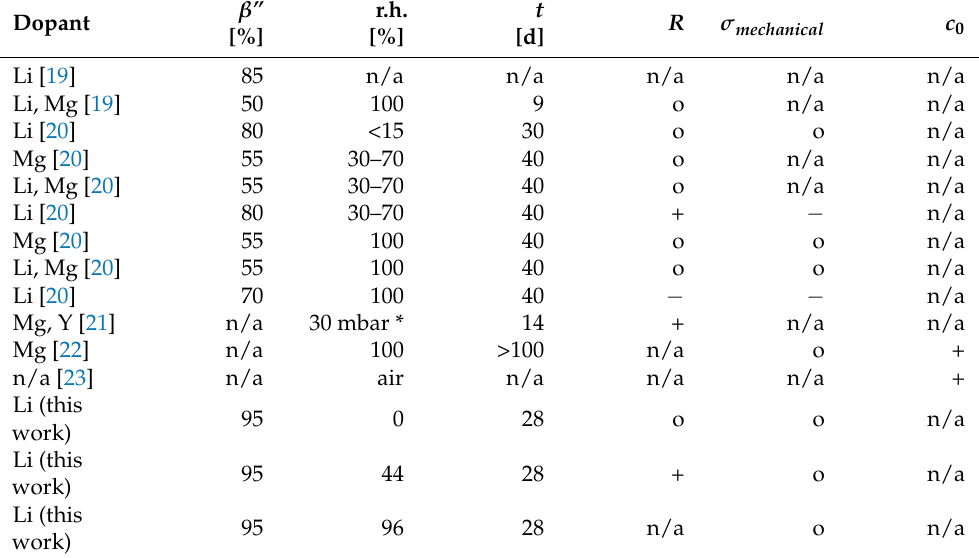
Table 1. Effects on differently stabilized sodium-beta aluminas stored in a humid atmosphere. β (cid:48)(cid:48) : β (cid:48)(cid:48) -phase content, r.h.: relative humidity, t: storage time in days, R: resistance, σ : mechanical strength, and c 0 : c 0 lattice parameter. *: H 2 O in N 2 (RT). n/a: no information was found in the corresponding reference. +: increase, − : decrease, and o: no